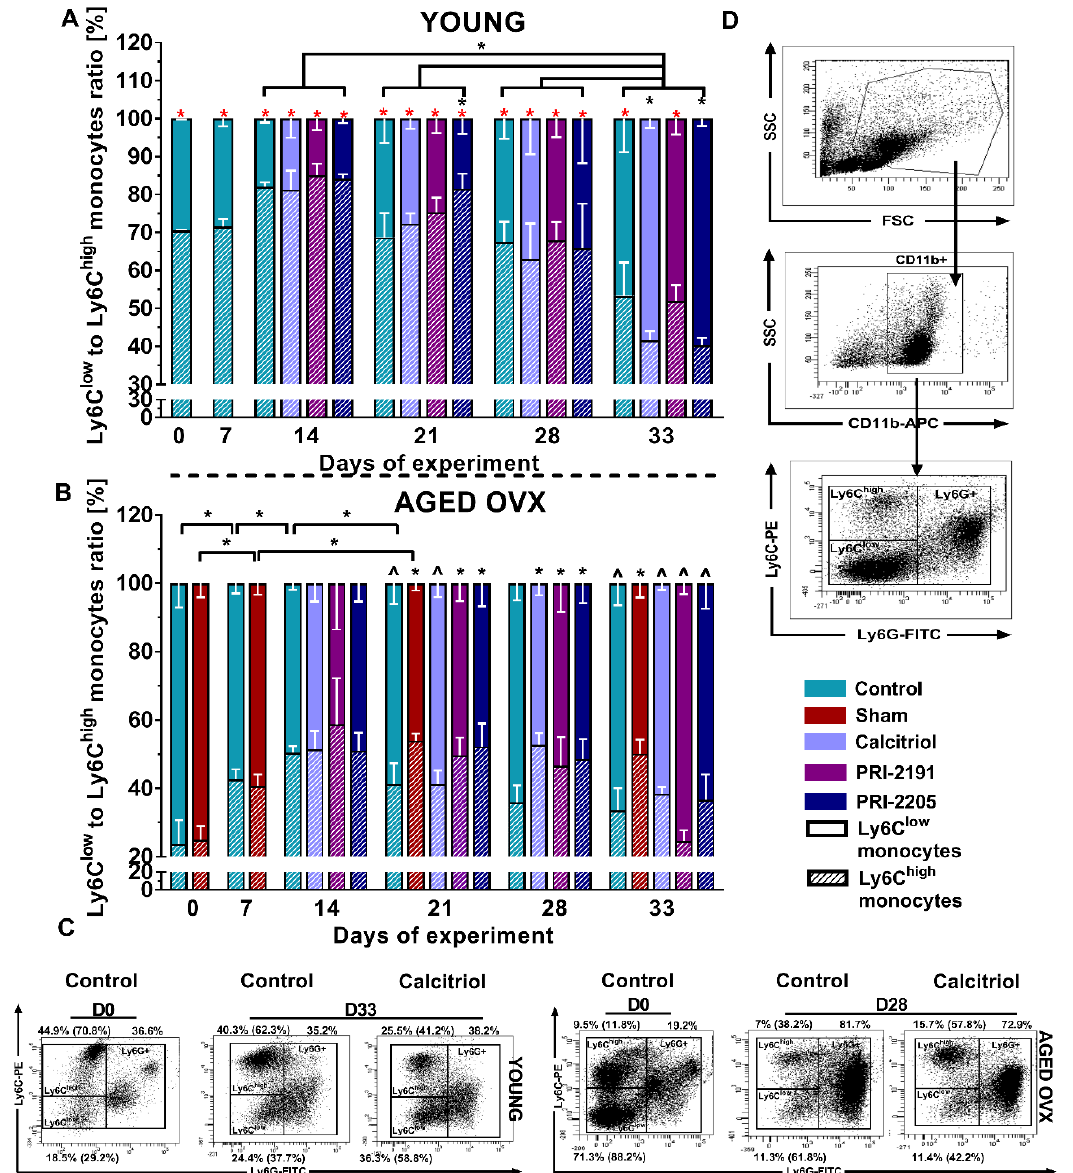
Figure 2. The Ly6C low to Ly6C high ratio of splenic monocytes in 4T1 tumor-bearing young and aged OVX mice. Ly6C low to Ly6C high ratio of splenic monocytes in ( A ) young or ( B ) aged OVX mice is presented. ( C ) Representative dot plots of selected analysis with the % of cells of each gate performed on days 0 and 28, and 33. The values in parentheses represent the percentage of monocytes of individual classes among all monocytes. ( D ) Gating strategy used in the analysis. 1 × 10 6 viable cells were used for cytometric analysis. Firstly, monocytes were gated as CD11b-positive and Ly6G-negative cells. Then, the monocytes were differentiated due to the expression of the Ly6C marker.